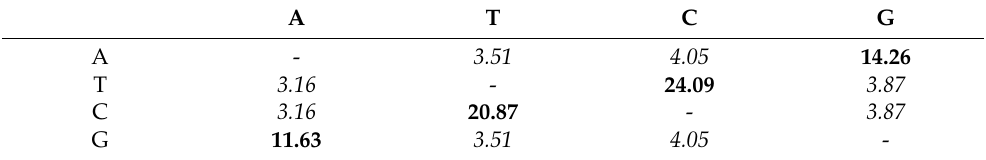
Table 2. Maximum composite likelihood estimate of the pattern of nucleotide